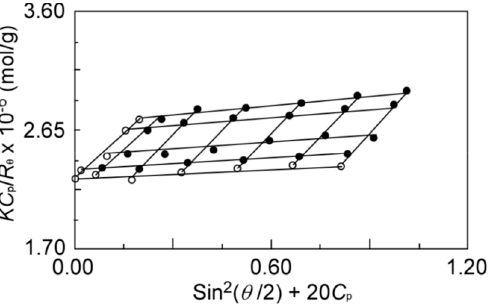
Figure 5. A representative Zimm plot of P(MPC/DMA 19 ) in 0.1 M NaCl aqueous solution.